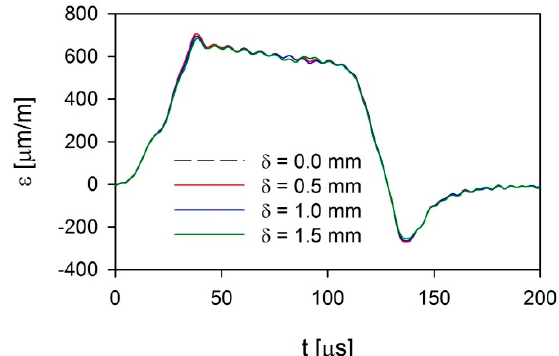
Figure 9. Reflected disturbed pulses for SHPB using a pulse shaper for an imperfection in the form of neutral axis offset δ .